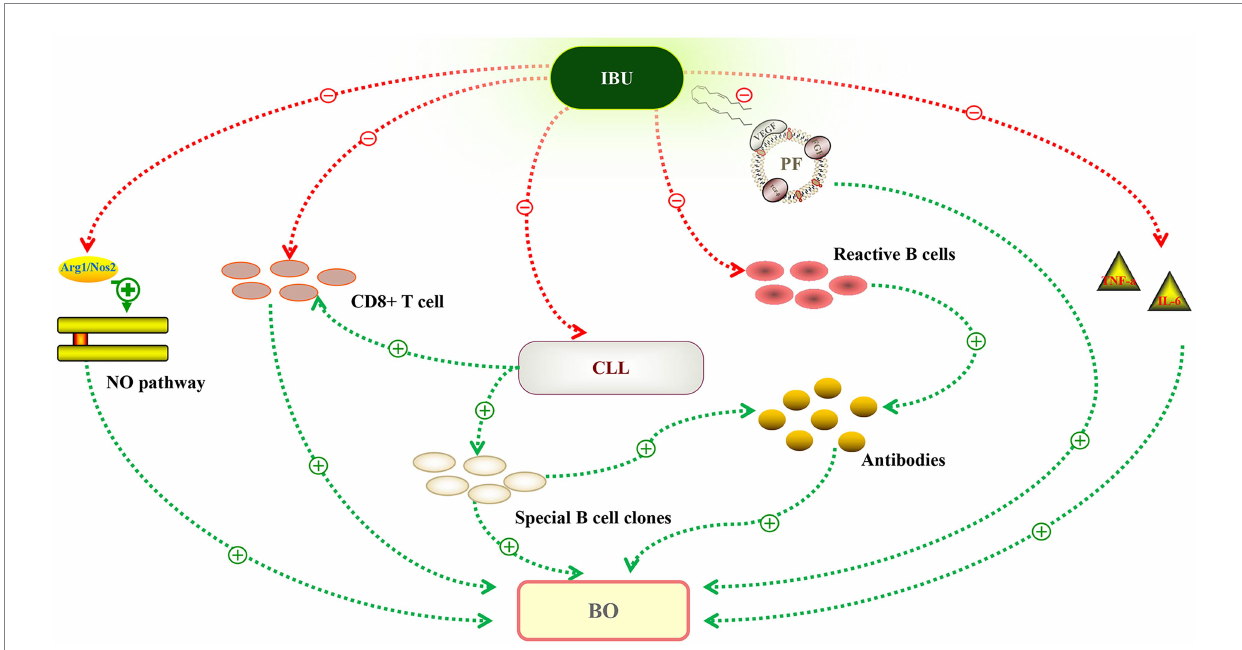
FIGURE 2 Potential mechanism of ibrutinib in the treatment of bronchiolitis obliterans (BO). Autoantibodies against plakin and desmoglein proteins could recognize the antigens expressed in stratified squamous epithelia and transitional columnar epithelia. Ibrutinib reduced the production of antibodies by inhibiting special B cell clones or reactive B cells. Chronic lymphocytic leukemia (CLL) cells may impair T-cell effector function, leading to a proliferation of infiltrating CD8+ T lymphocytes invading the bronchiolar walls. Ibrutinib targets CLL, and after treatment, CD8+ T cells decreased significantly. The nitric oxide (NO) pathway plays a significant role in BO, and ibrutinib treatment decreased NO production by downregulating Nos2 expression. Ibrutinib may also inhibit inflammatory changes, including the inflammatory cytokines (IL-6, TNF-a) and vascular endothelial growth factor (VEGF). Green line, promote. Red line,